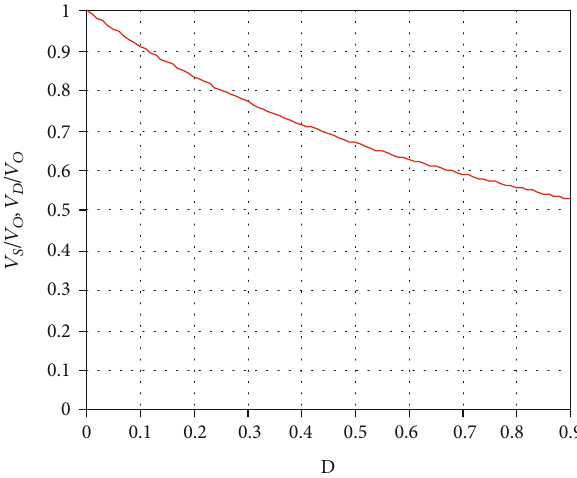
Figure 9: The relationships between voltage stress on switches and diodes with duty